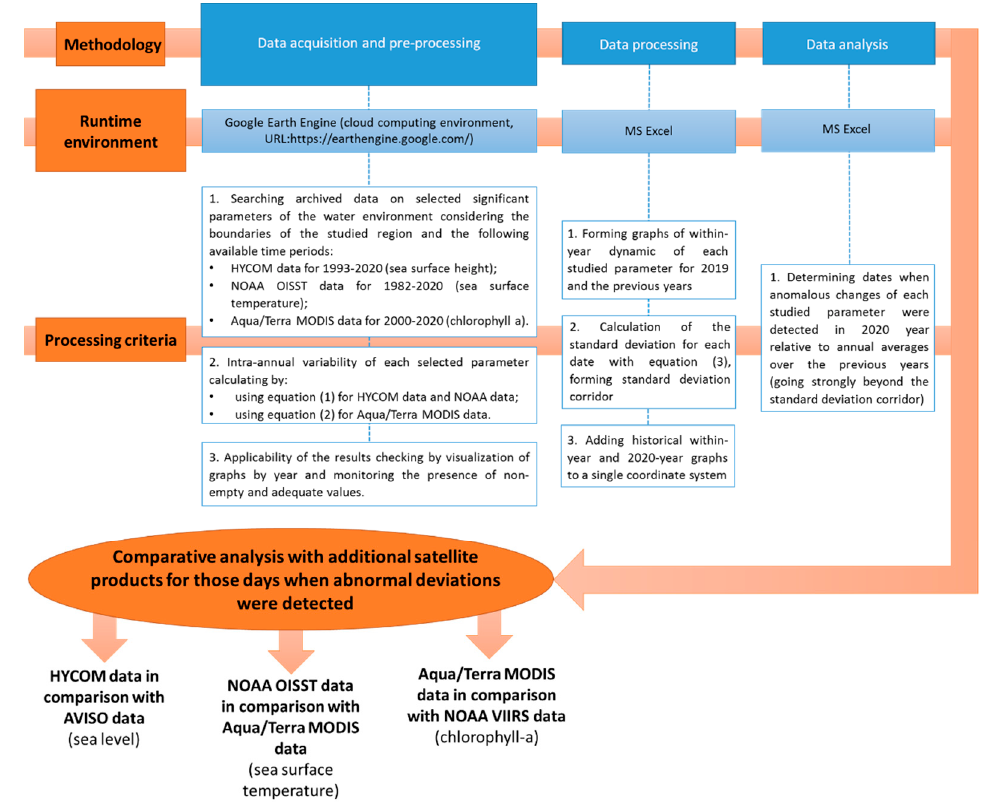
Figure 2. Flowchart of the experiment for processing of long-term retrospective series of satellite data on the ocean level, sea surface temperature, and chlorophyll-a concentration.